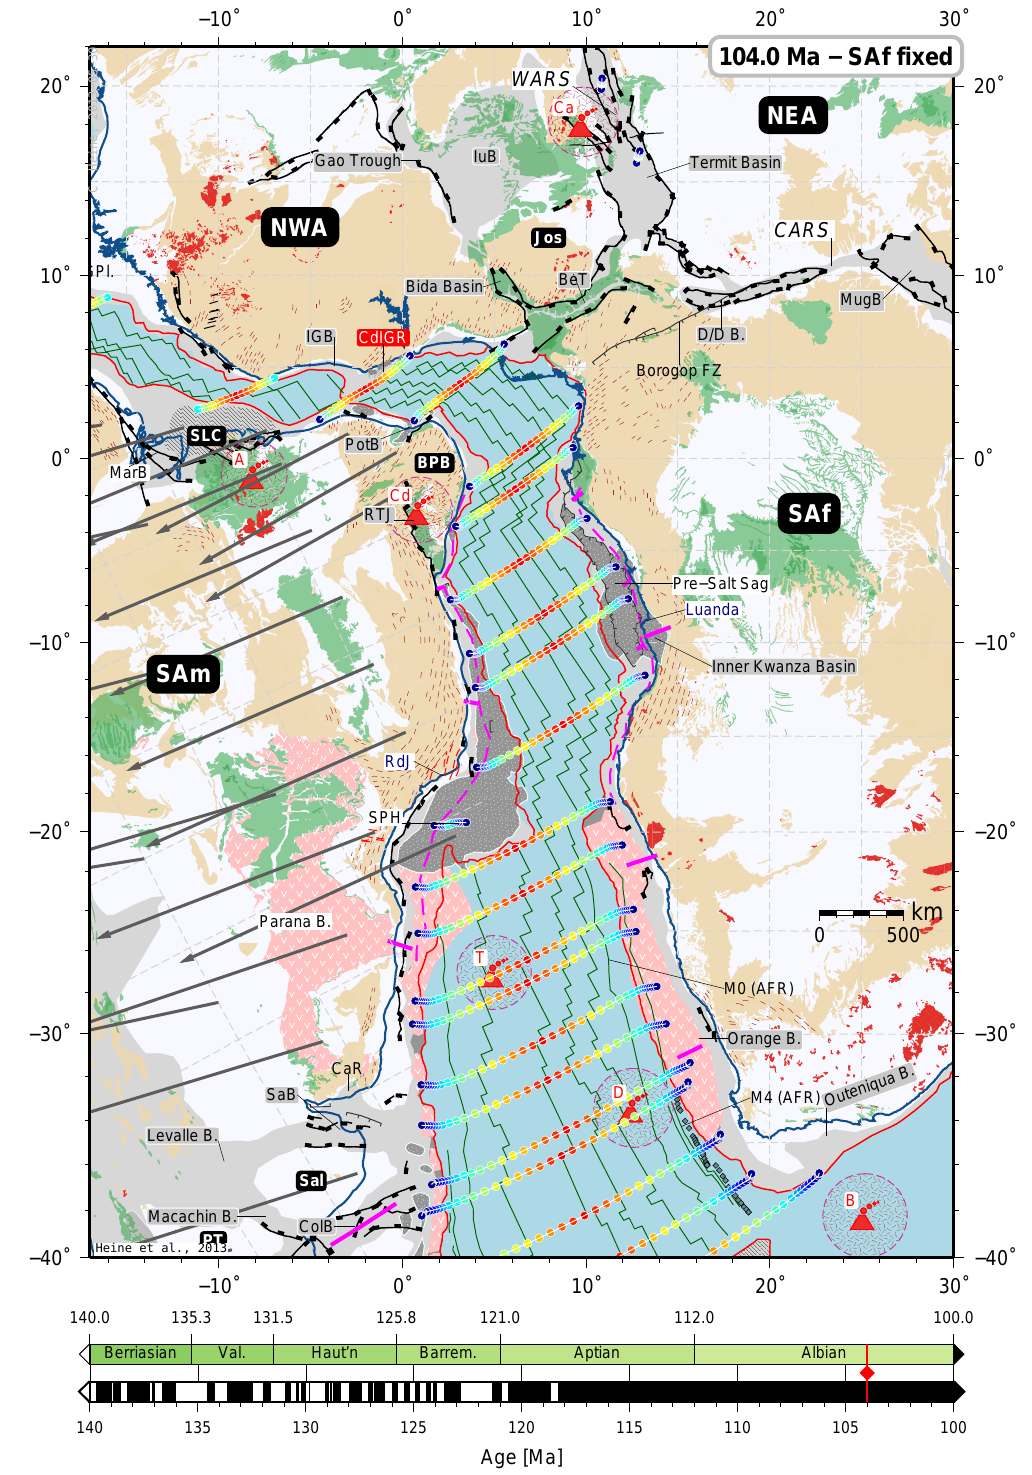
Fig. 21. Plate tectonic reconstruction at 104Ma, with Africa fixed in present-day coordinates. For map legend see Fig. 22, abbreviations as in Fig. 13. Full continental separation is achieved at this time, with narrow oceanic gateways now opening between the Cˆote d’Ivoire/Ghana Ridge and the Piaui-C´eara margin in the proto-equatorial Atlantic and between the Ewing Bank and Aghulas Arch in the southernmost South Atlantic. Deformation related to the break-up between Africa and South America in the African intracontinental rifts ceases in post-Aptian